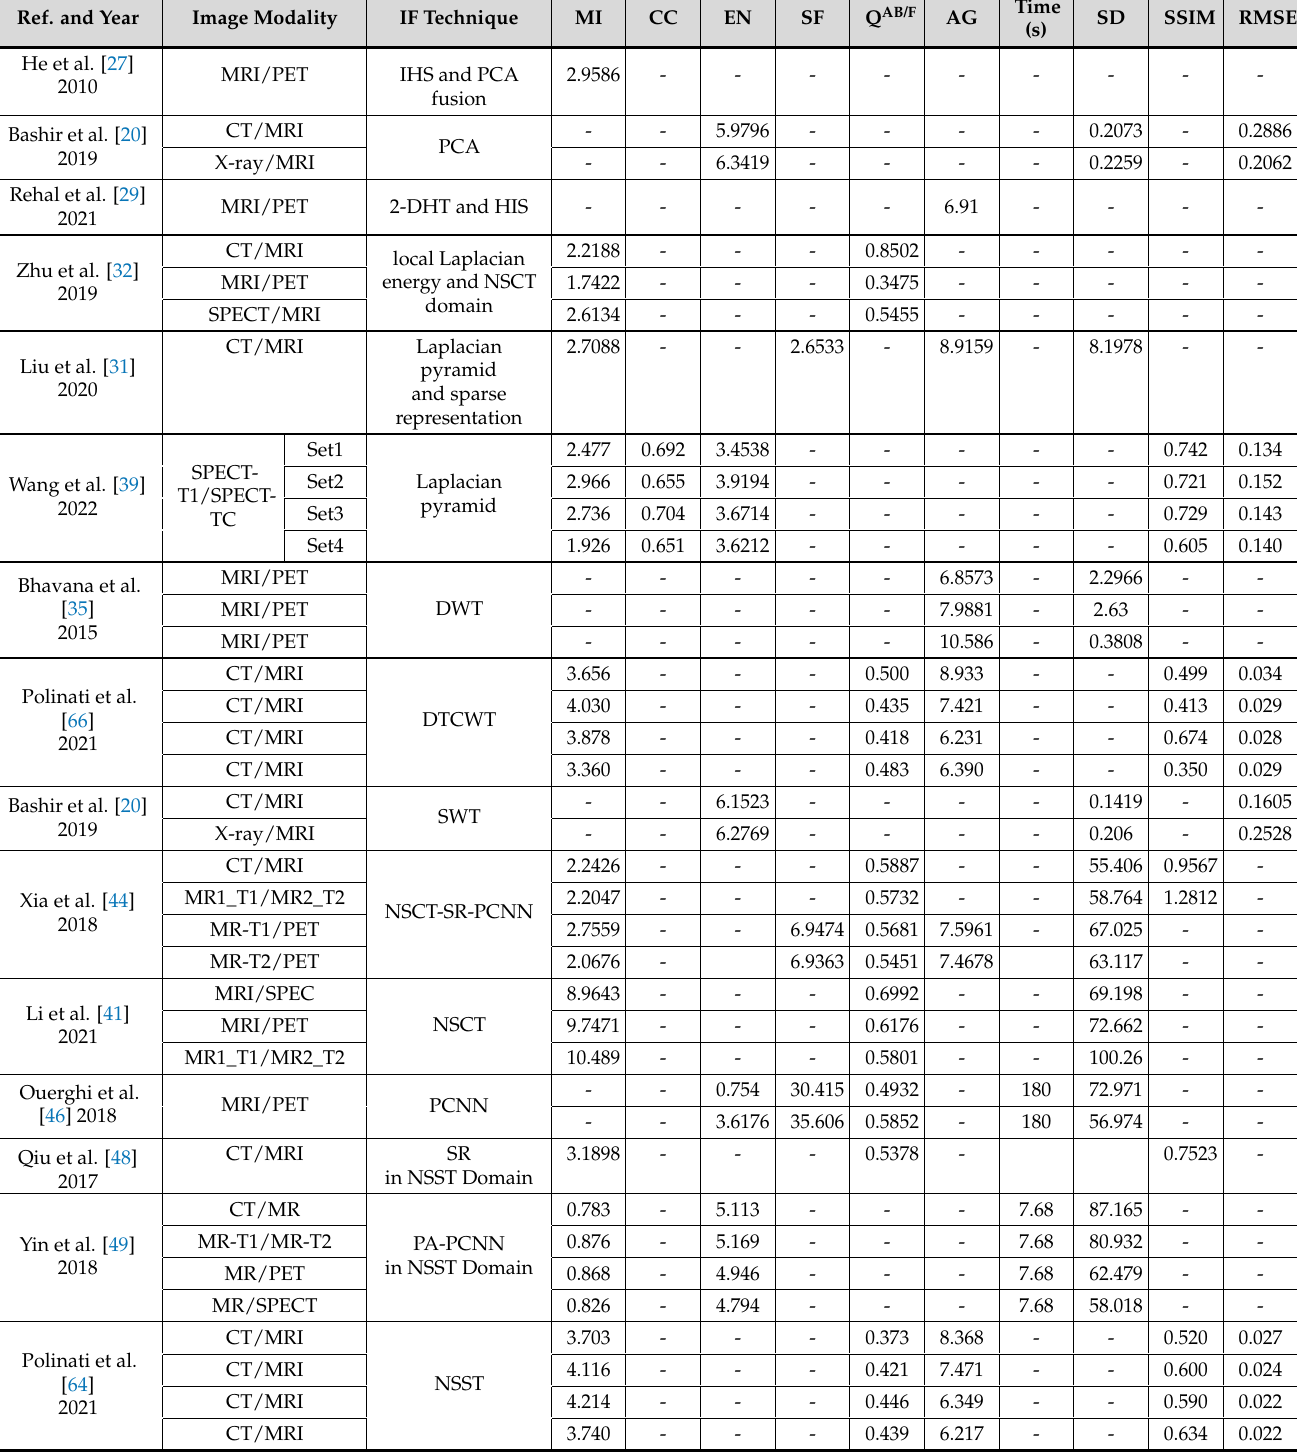
Table 4. Comparison of performance evaluation